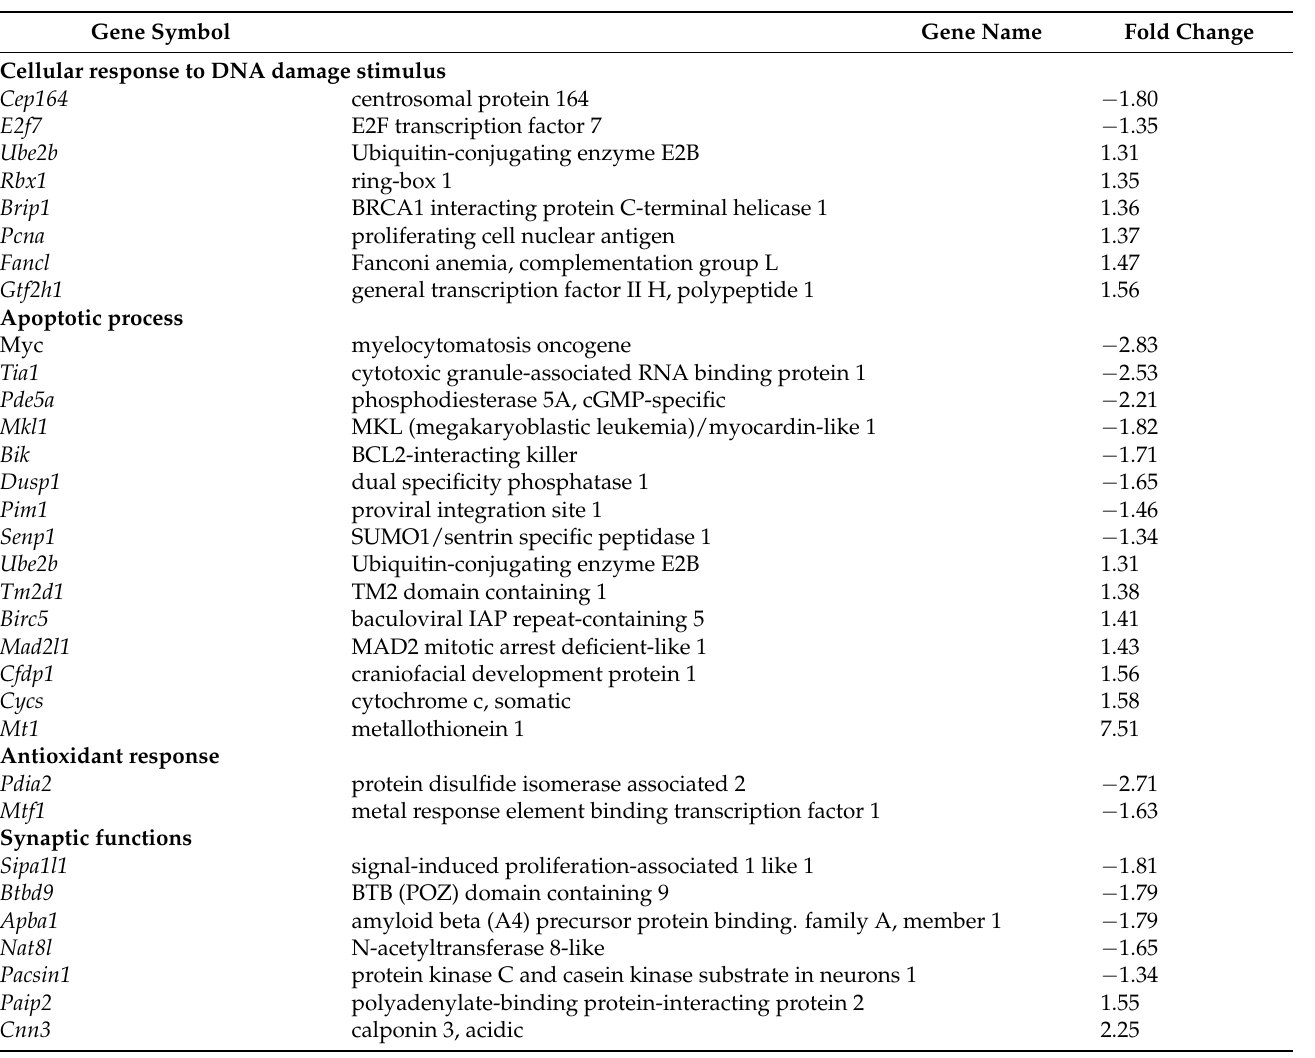
Table 1. Pathways of interest with genes differentially expressed in NSC-34 expressing superoxide dismutase 1 wild type (SOD1) WT in presence of 1 mM H 2 O 2 for 3 h ( p < 0.05, fold change ≥ 1.3). Gene Symbol Gene Name Fold Change Cellular response to DNA damage